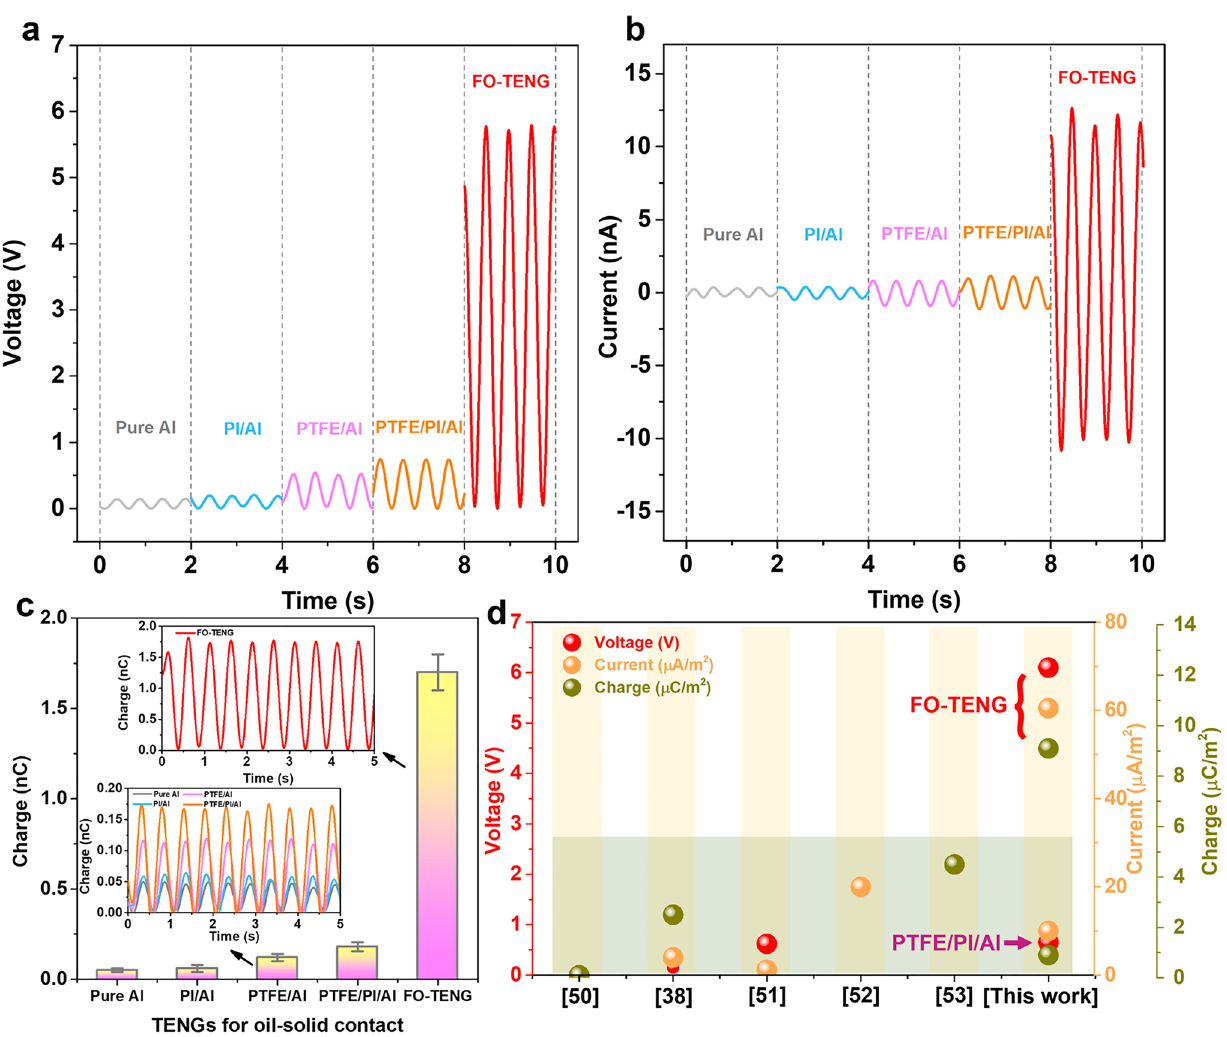
Fig. 2 Electrical output performance of O-TENG. a‑c The open-circuit voltage, short-circuit and transferred charge curves of the FO-TENG (18–20) compared with other O-TENGs for oil-solid contact. d Comparison of the triboelectric output performance for oil–solid contact in past